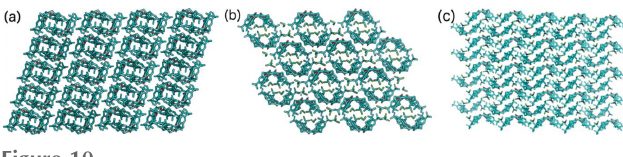
Figure 10 The crystal packing of 11 , 12 and 13 , showing the off-set bilayers.